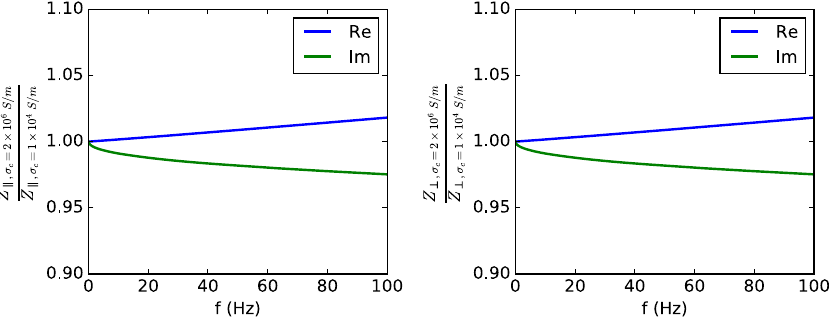
FIG. 2. Ratio of the impedance of two-layer beam pipe with coating conductivities of 2 × 10 6 S = m and 10 4 S = m as given by I MPEDANCE W AKE 2 D. A copper pipe of 35 mm of radius with a coating thickness of 100 nm has been used. On the left side the longitudinal impedance is shown, with the real part in blue and the imaginary one in green, and on the right side the transverse